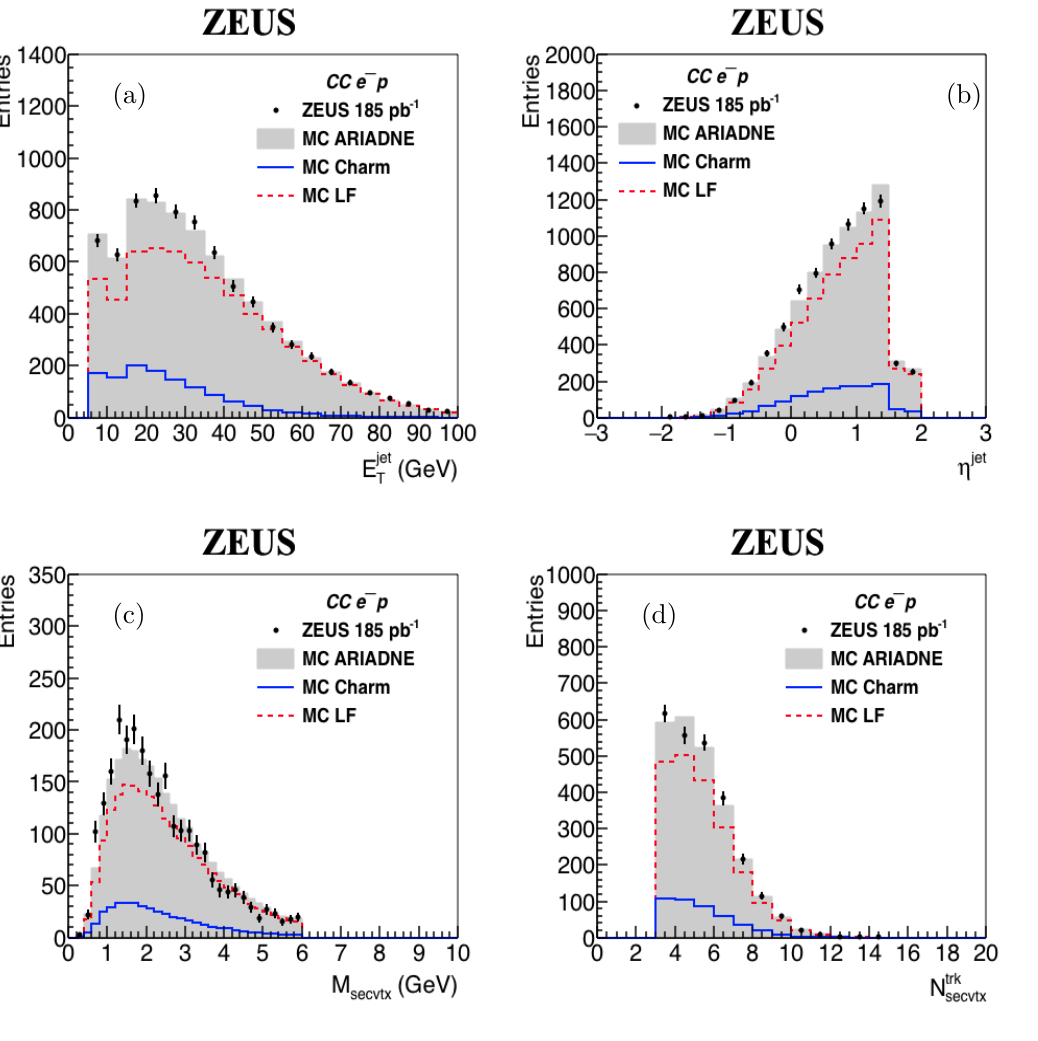
Figure 6. Comparison between data (points with vertical error bars) and MC (histogram) for jet and secondary-vertex distributions: (a) E jet The labels are the same as in (cid:12)gures 3 and